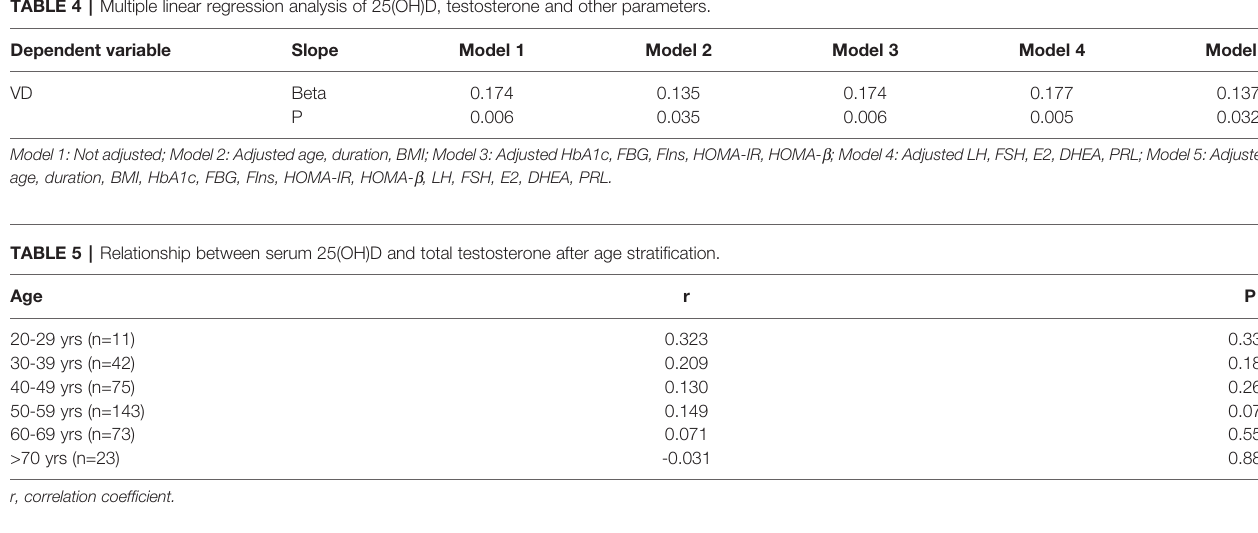
TABLE 6 | Relationship between serum 25(OH)D and total testosterone after duration strati fi cation. Duration (years) r P <1